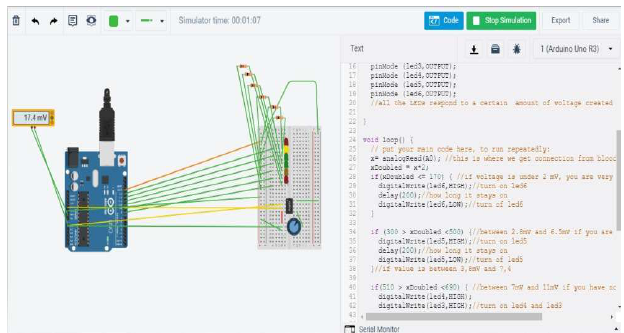
Fig: When Glucose level is high, the LED 2 (yellow) blinks